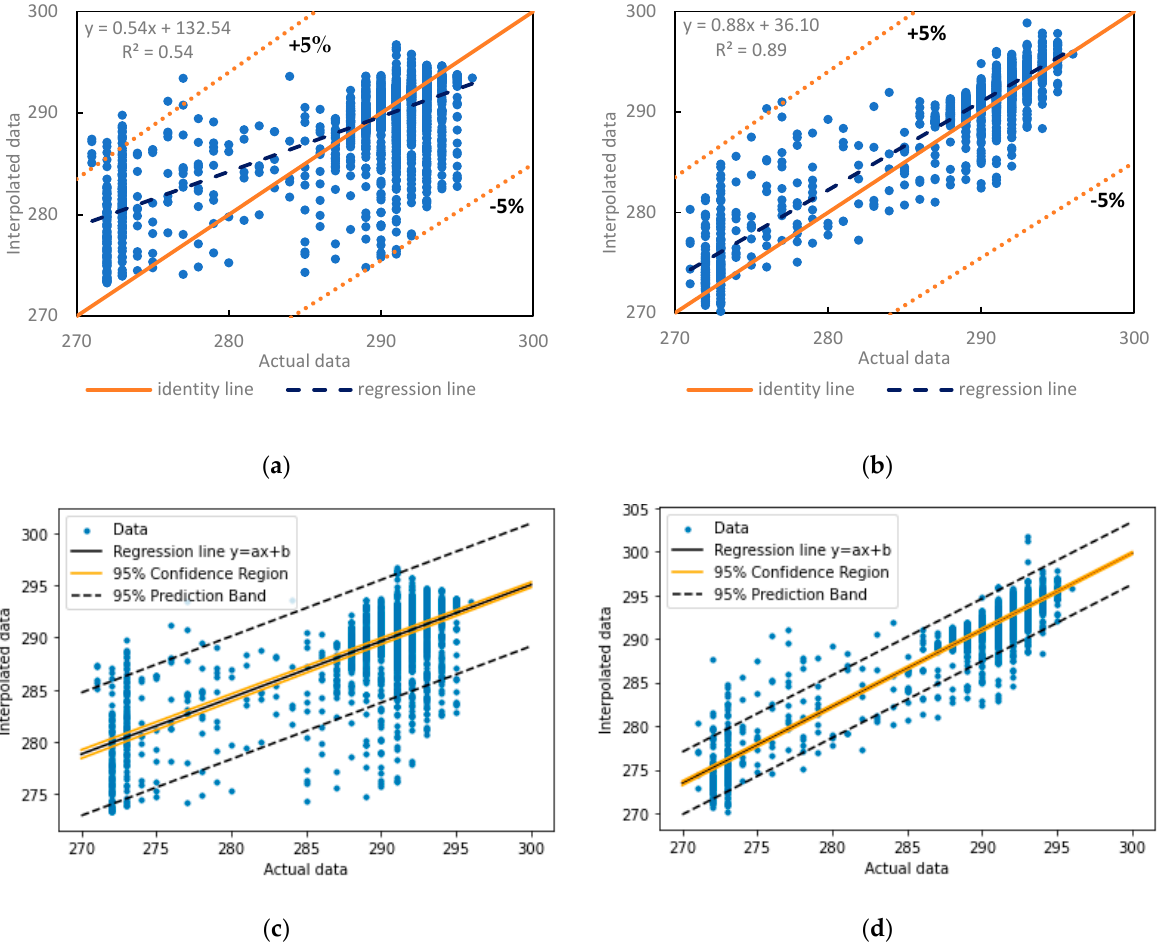
Figure 6. Scatter plots of interpolated and actual soil temperature, identity, and regression lines of ( a ) RBFN ( b ) Deep learning; confidence and prediction bands of ( c ) RBFN ( d ) Deep learning.